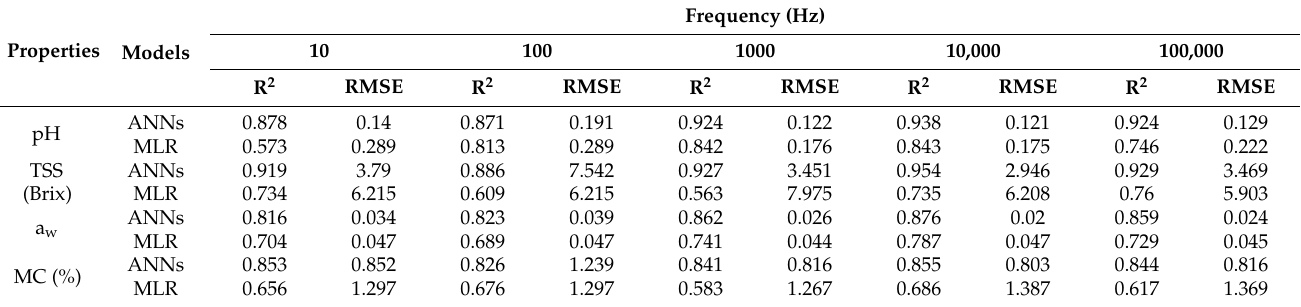
Table 7. Comparison between values of R 2 and RMSE for the developed ANNs and MLR models in the evaluation phase at various